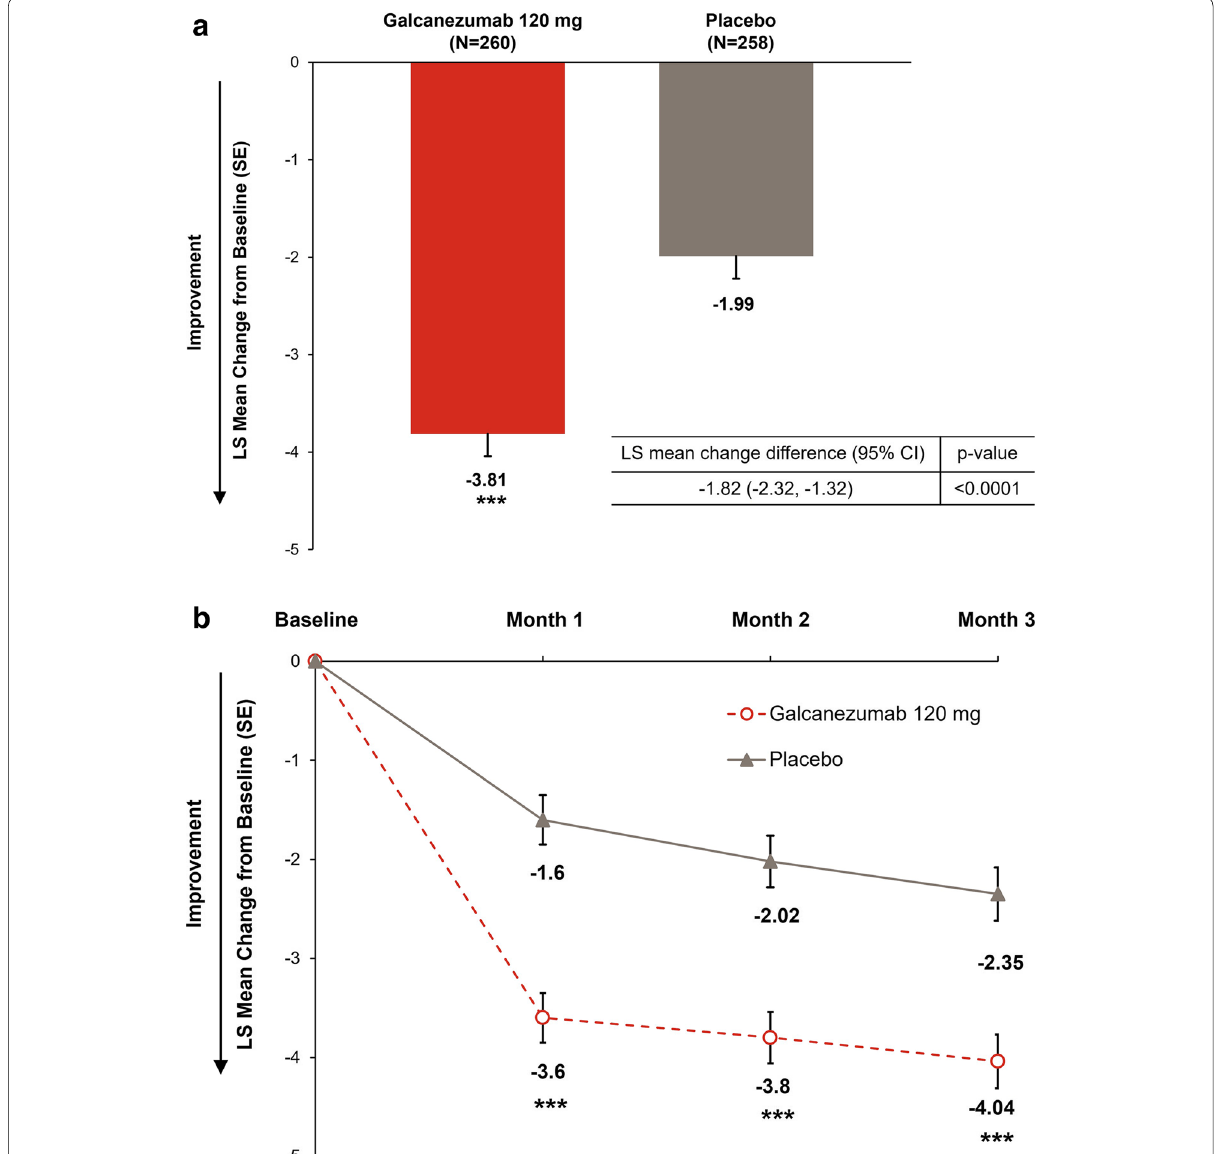
Fig. 3 a Overall LS mean change from month 1 to 3 in monthly migraine headache days; b LS mean change at month 1 to 3 in monthly